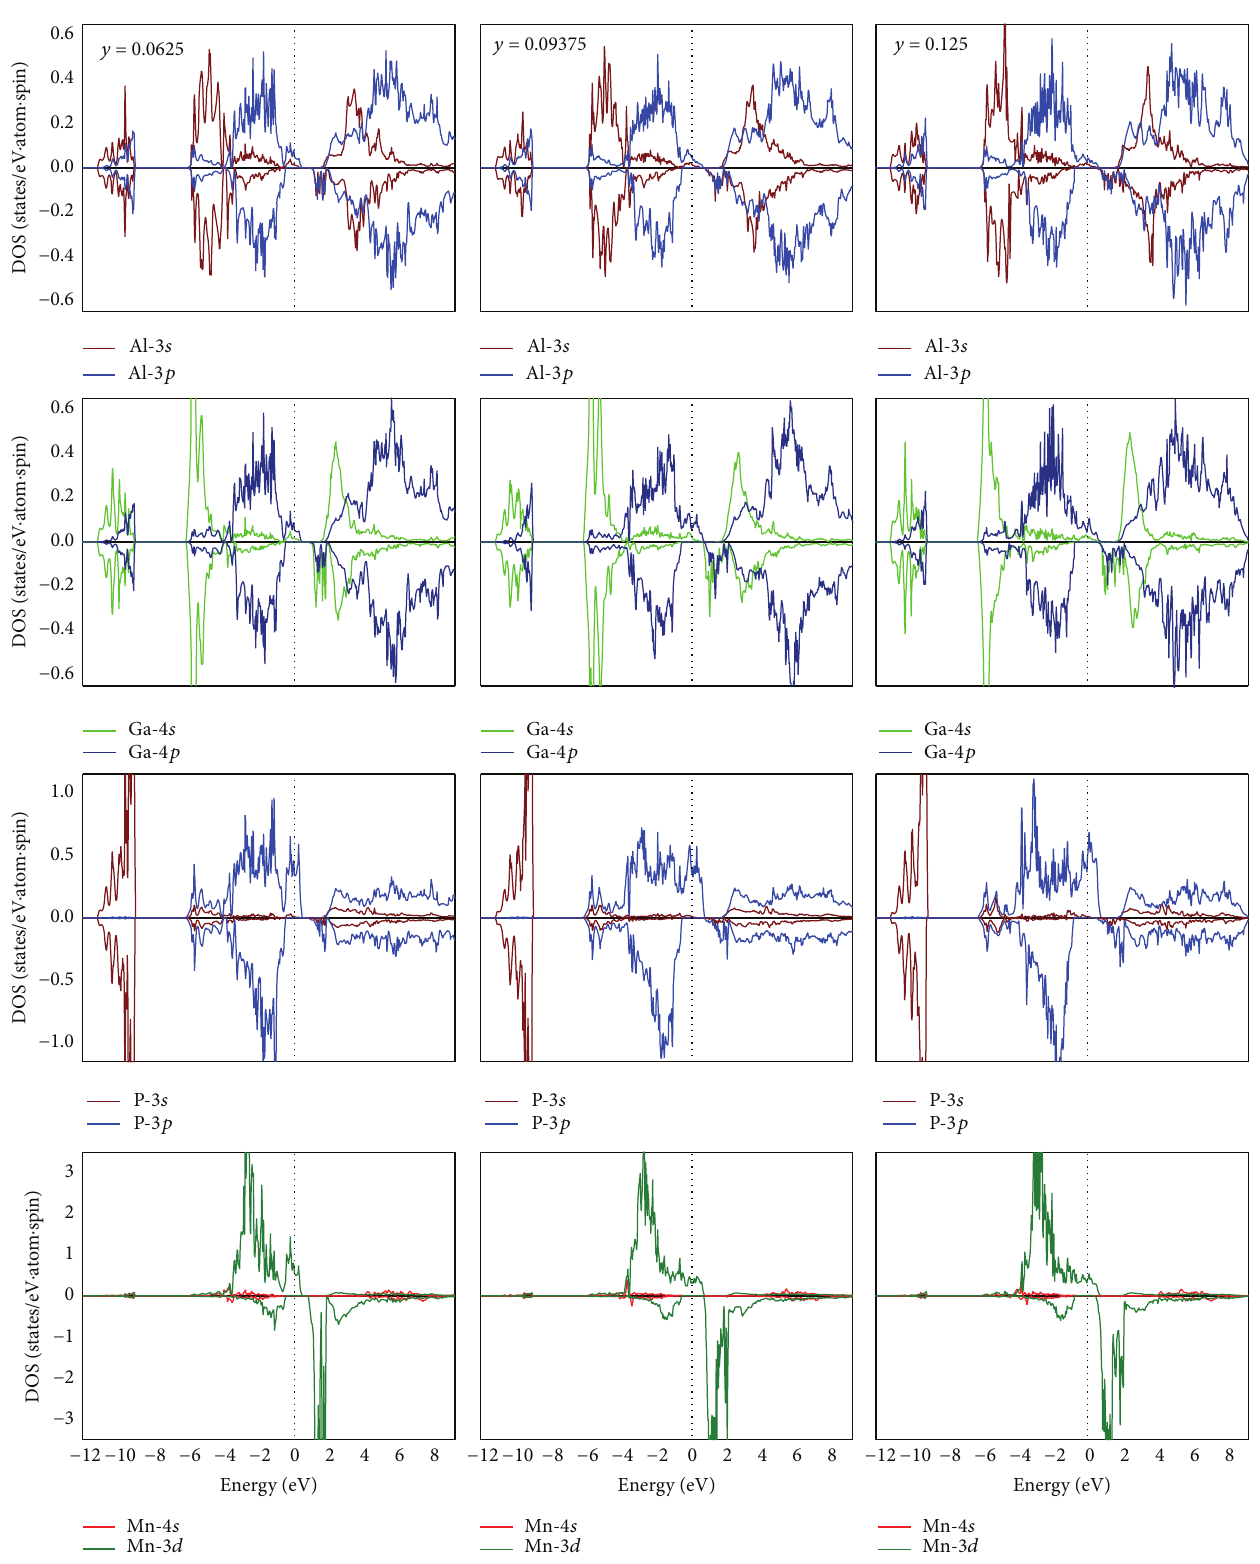
Figure 3: DOS for Al, Ga, P, and Mn sites of Ga-rich ( Al 1−𝑦 Mn 𝑦 ) GaP 2 with 𝑦 = 0.0625 , 0.09375, and 0.125 in the FM state. The Fermi level is set to